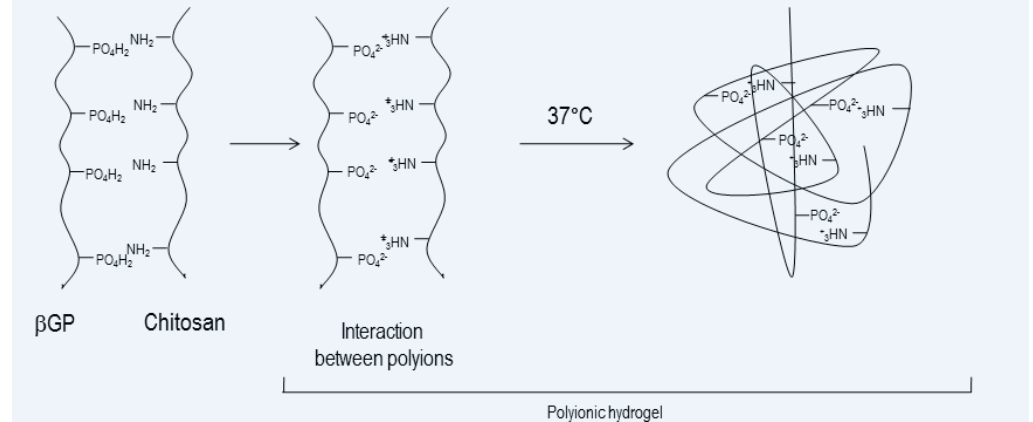
Figure 3. Schematic representation of gelification process between chitosan and β -glycerophosphate ( β